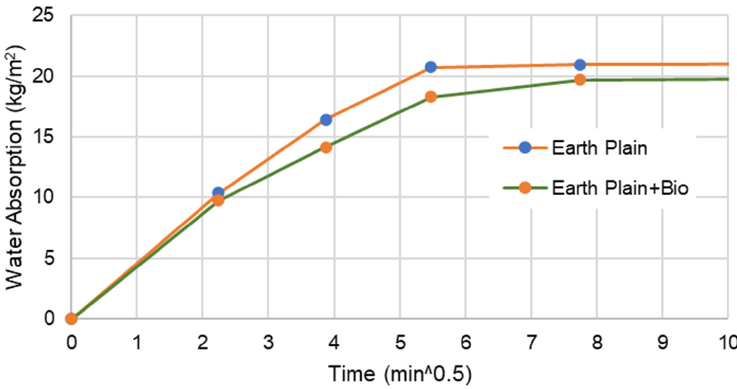
Figure 5. Water absorption for bio and non-bio earth mortar samples after 28 days. Coefficient of variation (CoV) per family of mortar: earth mortar: 2.8%; earth+bio: 3.8%.